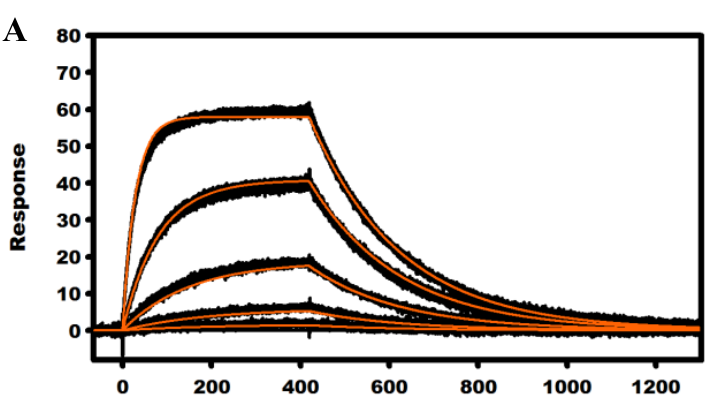
Figure 5. Classical kinetics of rFabs, ( A ) 14F11; ( B ) 9C3 and ( C ) chained-shuffled construct, binding to immobilized ricin. Recombinant Fabs, (concentrations of 0, 0.5 nM, 2 nM, 8